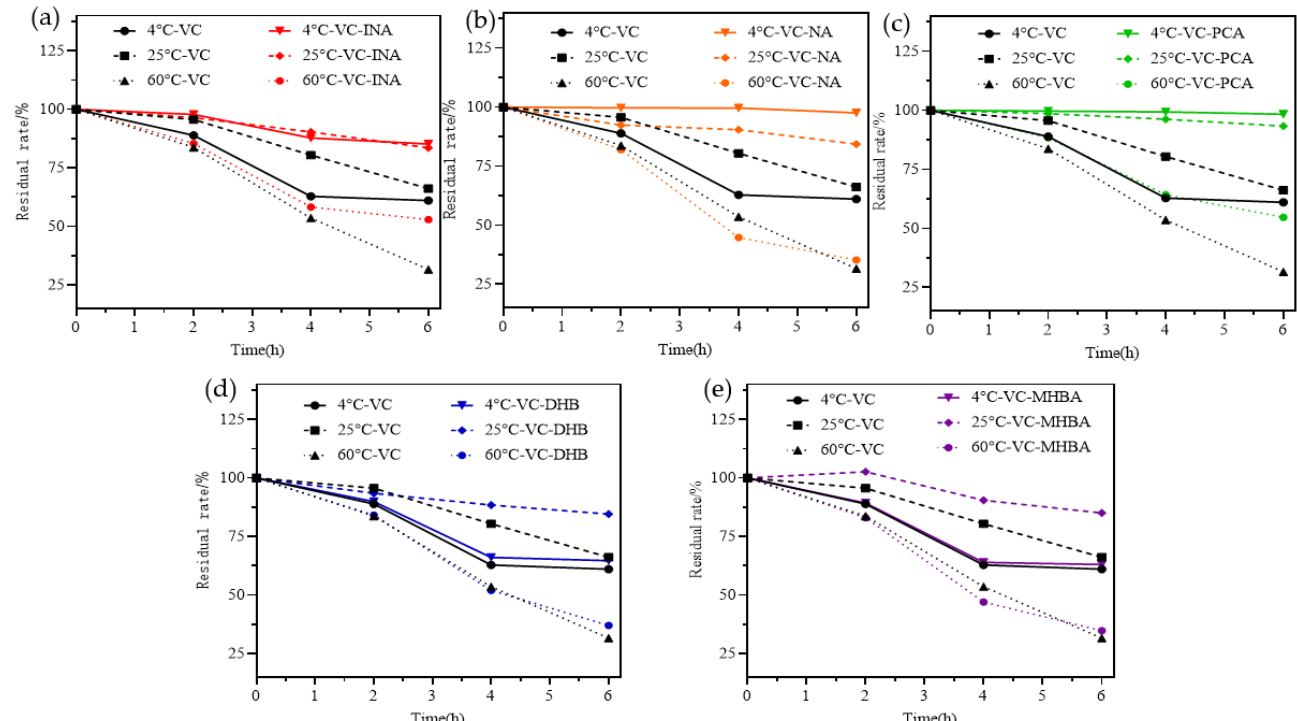
Figure 8. Thermostability of VC co-crystals (( a ): VC-INA; ( b ): VC-PCA; ( c ): VC-NA; ( d ): VC-DHB; ( e ): VC-MHBA).